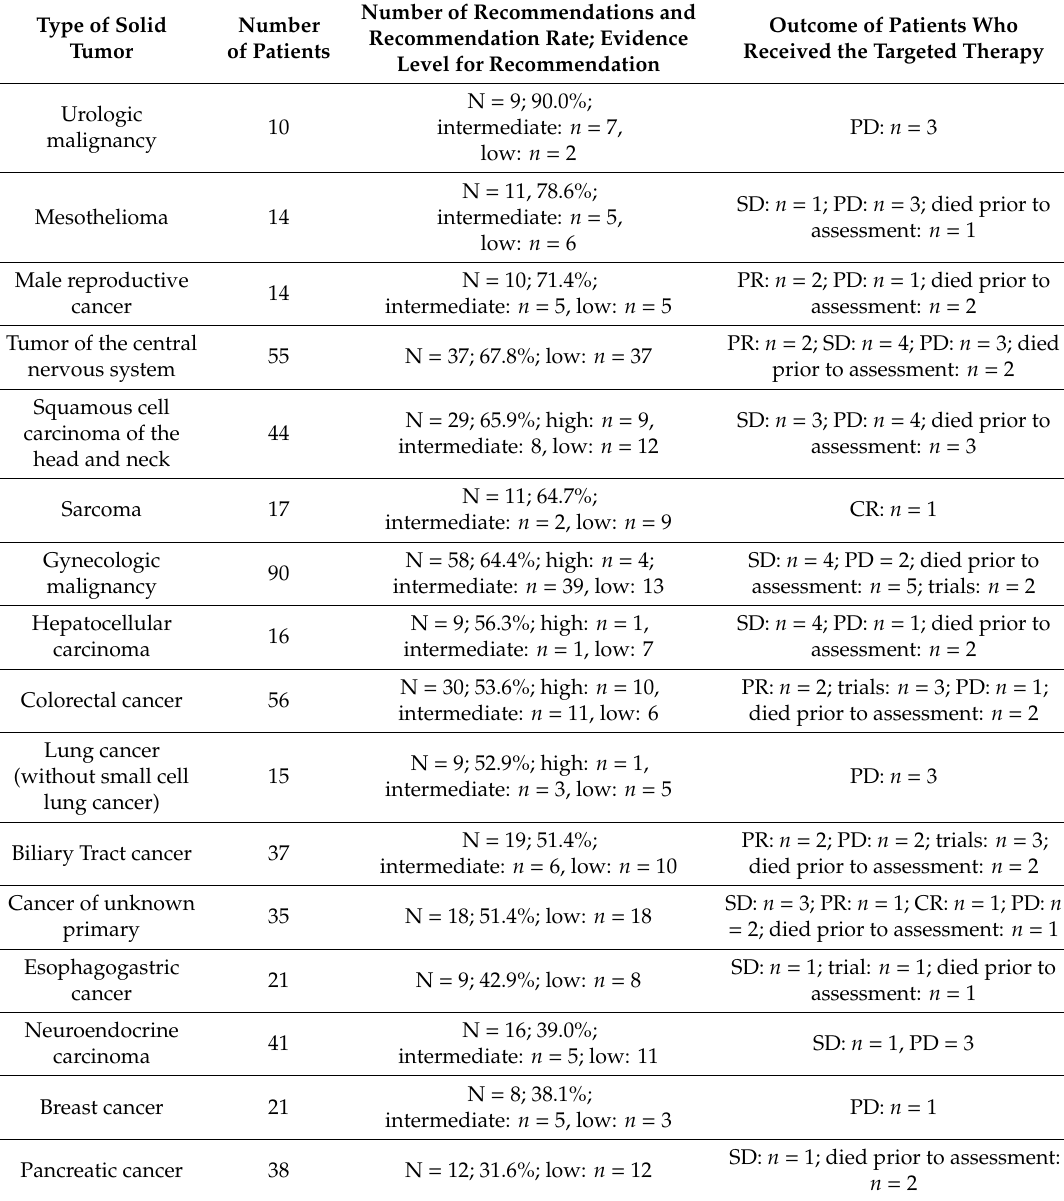
Table 2. Number of patients and recommendation